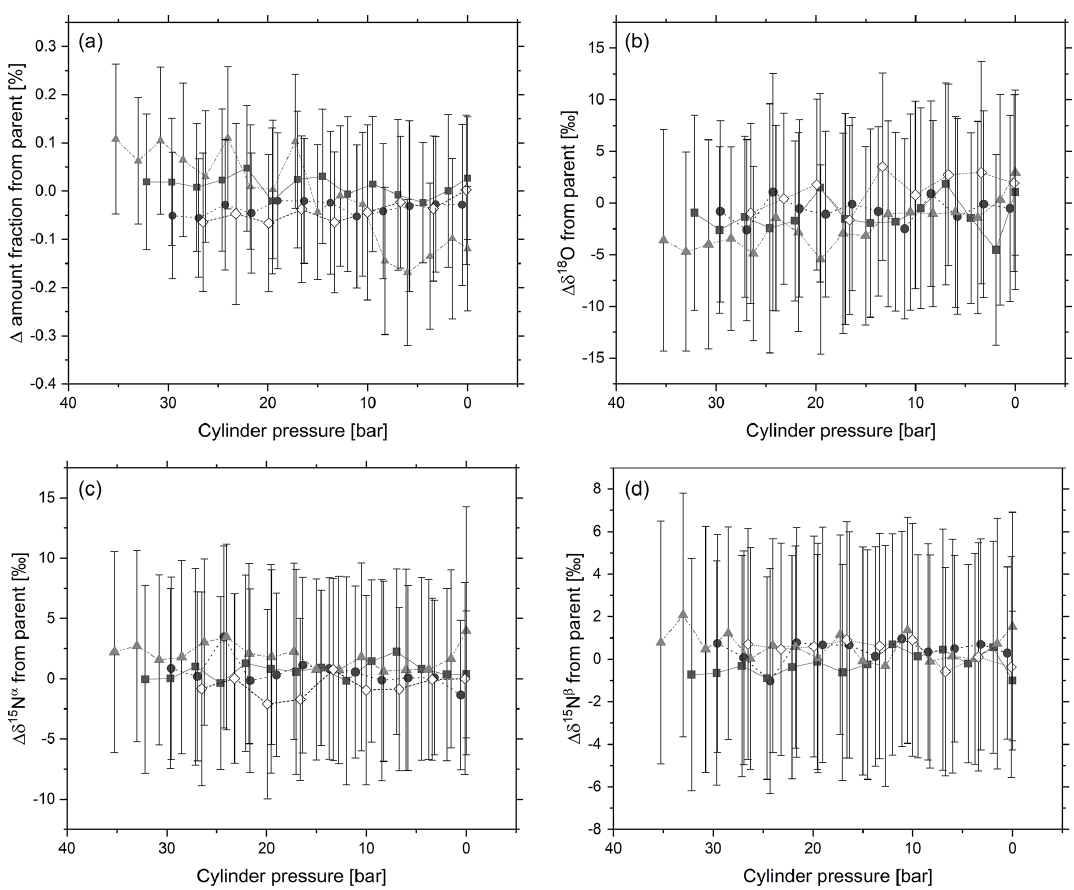
Figure 5. Temporal change in (a) N 2 O amount fraction and delta values: (b) δ 18 O, (c) δ 15 N α and (d) δ 15 N β in response to changes in cylinder pressure of four 0.85L aluminium cylinders. Each data point represents a 5min average of analyser response, and error bars represent 1 standard deviation across the 5min average.